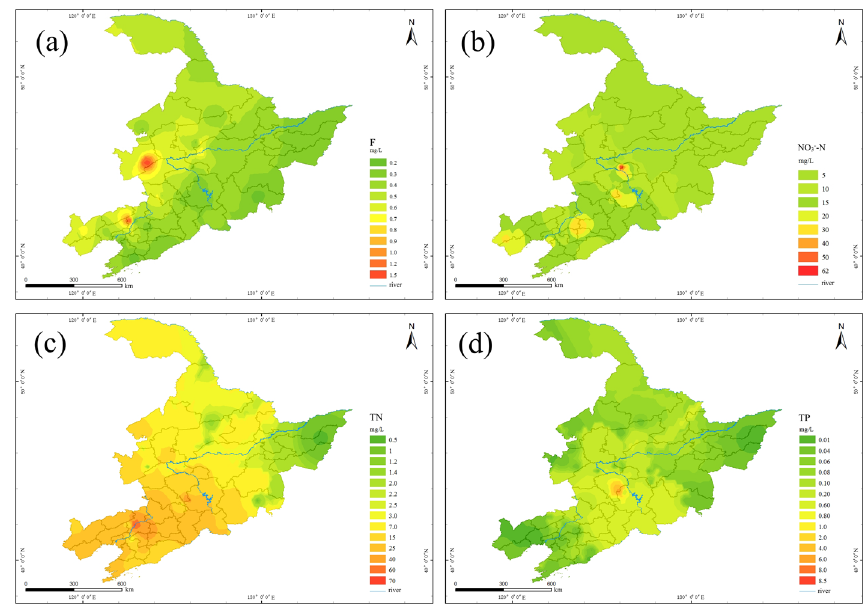
Figure 8. Prediction of Concentration Distribution of Inorganic Nonmetals in Drinking Water Sources in Typical Villages and Towns of Region M: ( a ) F, ( b ) NO 3 — N, ( c ) (TN) and ( d ) (TP).